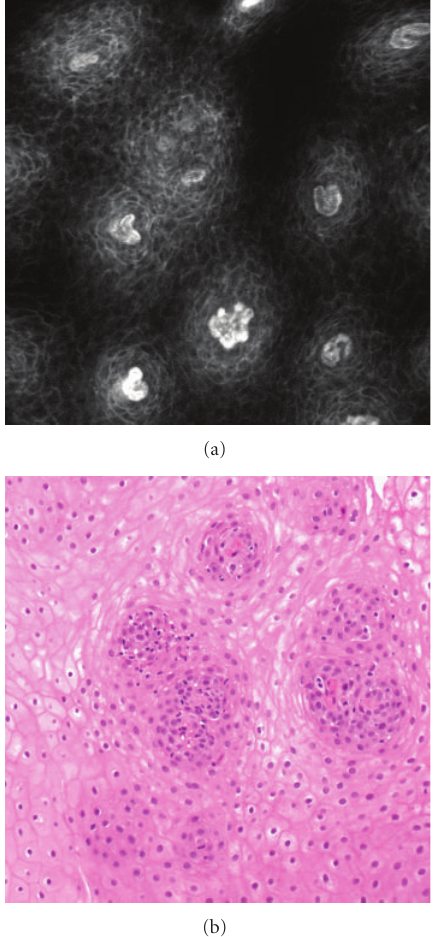
Figure 2: CLE image and histologic aspect (trasversal section) of the proximal treated esophageal area. Normal squamous esophagus showing individual epithelial cells and intrapapillary capillary